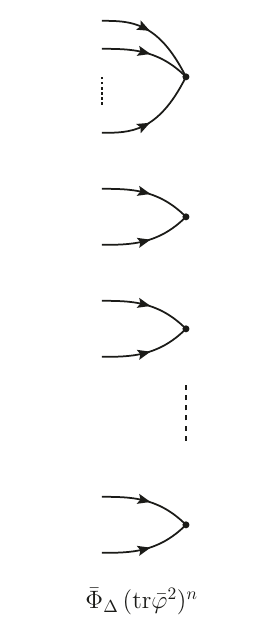
Figure 1 . The = 4 result is the full tree level contraction of this diagram. The chiral operator N is placed in x , the anti-chiral in